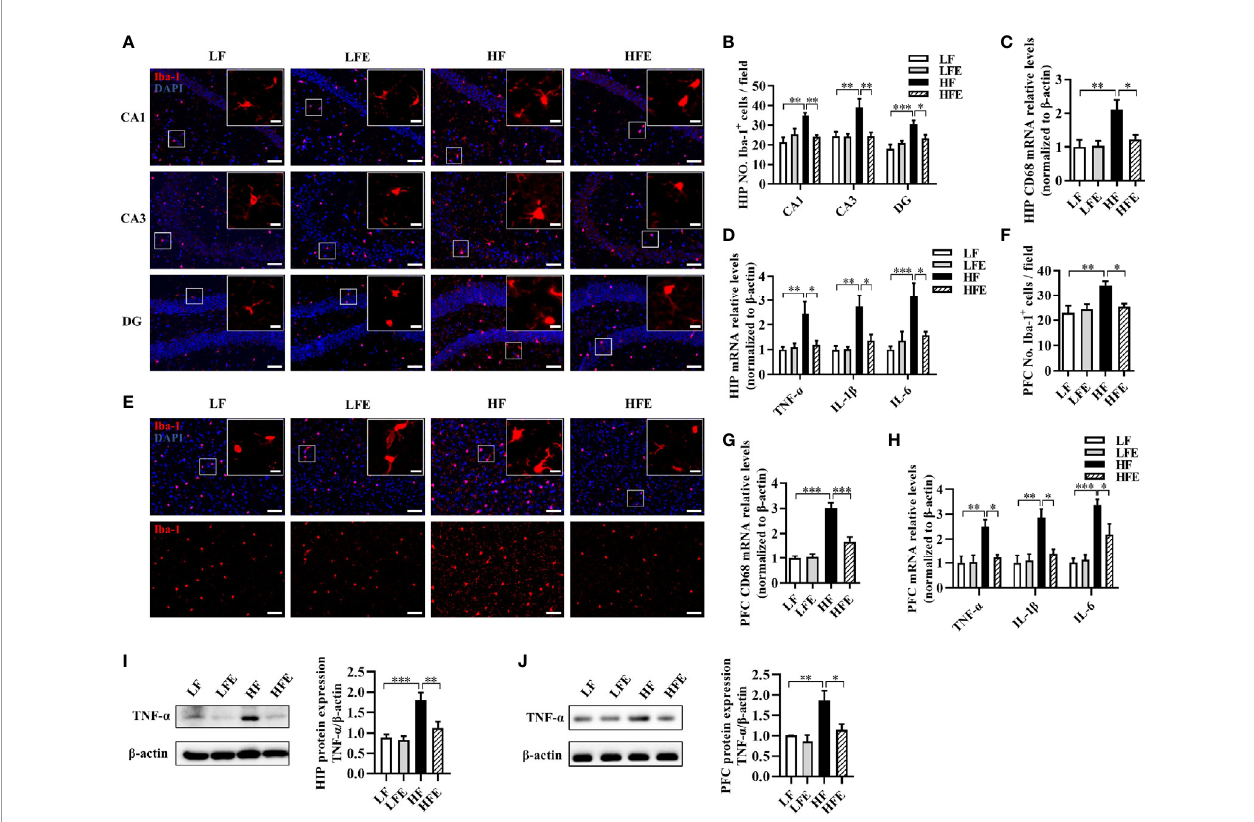
FIGURE 2 | ESPs supplementation suppressed microglial activation and in fl ammation in the hippocampus and prefrontal cortex of HF diet-induced obese mice. (A, B) Representative immuno fl uorescent staining and quanti fi cation of the ionized calcium-binding adaptor molecule 1 (Iba-1 + ) cells in the cornu ammonis 1 (CA1), cornu ammonis 3 (CA3), and dentate gyrus (DG) regions of the hippocampus (HIP) (n = 3, 2 images per mouse, scale bar 50 m m). The image captured from the box was marked with a solid line (scale bar 10 m m). (C, D) The mRNA expression levels of the cluster of differentiation 68 (CD68) and proin fl ammatory cytokines, including the tumor necrosis factor-alpha (TNF- a ), interleukin-1 beta (IL-1 b ), and interleukin-6 (IL-6) in the HIP (n = 6). (E, F) Immuno fl uorescent staining and quanti fi cation of Iba-1 + cells in the prefrontal cortex (PFC) (n = 3, 2 images per mouse, scale bar 50 m m). (G, H) The mRNA expression levels of CD68 and proin fl ammatory cytokines, including TNF- a , IL-1 b , and IL-6 in the PFC (n = 6). The relative mRNA levels were normalized with reference gene ( b -actin). (I, J) The protein expression levels of TNF- a in the HIP and PFC (n = 8). Values are represented as mean ± SEM. * P < 0.05, ** P < 0.01, *** P < 0.001. Tukey-Kramer